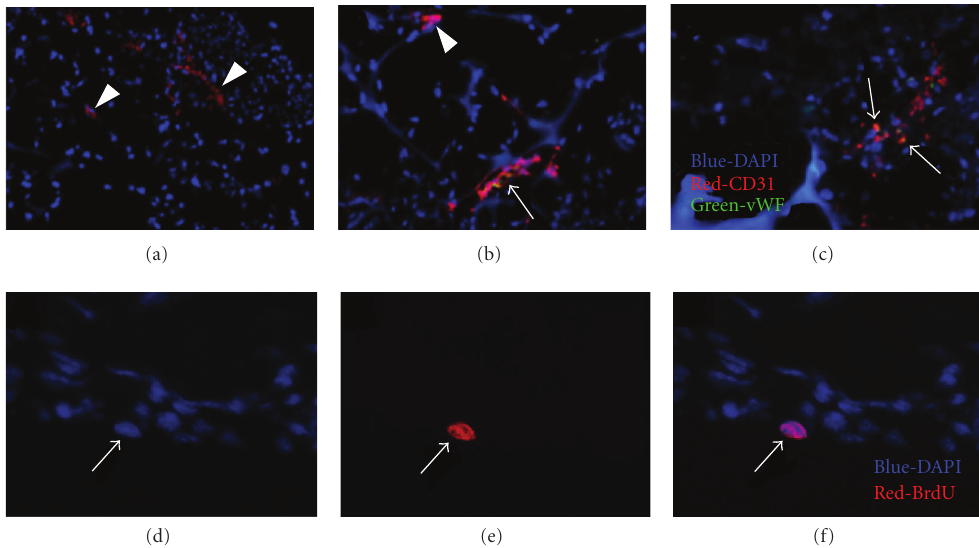
Figure 2: Immunofluorescent staining of the sca ff olds after culturing for 1, 2, and 3 weeks in vitro for evidence of vasculature ((a)–(c)). After one week of culturing (a), CD31 positive cells ( red ) are detected within the sca ff old. After two weeks of culturing (b), colocalization of CD31 ( red ) and vWF ( green ) positive cells are visualized. After three weeks of culturing (c), more extensive colocalization of CD31 and vWF is seen. A BrdU assay was performed in vitro after 10 days of culturing ((d)–(f)). BrdU positive nuclei ( red ) were seen revealing that proliferation was occurring throughout the sca ff old (e).